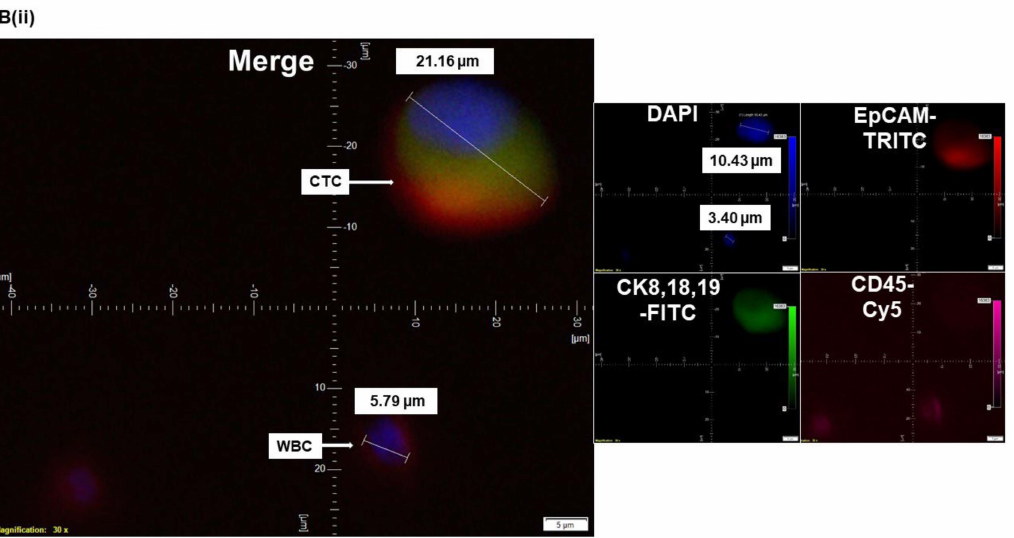
Figure 2. Validation spectrum of CTC by IF × 3 using blood from patients with different clinical statuses and samples of origin: CTC from blood samples from patients with ( A ) clinical status, nonmetastatic ( Ai ) and metastatic ( Aii ) in endometrial cancers, and ( B ) samples of origin, during a biopsy from a patient with metastatic liver cancer ( Bi ) and during surgical resection of the tumor in lung cancers ( Bii ) are presented. The magnification, scale bar, and digital reticle are presented for each photomicrograph. Fluorescence images from DAPI, FITC, TRITC, and Cy5 channels were separated as pictures with a color bar. The fluorescence-photomicrographs presented the diameters ( µ m) of CTC and a representative WBC and their respective DAPI stained